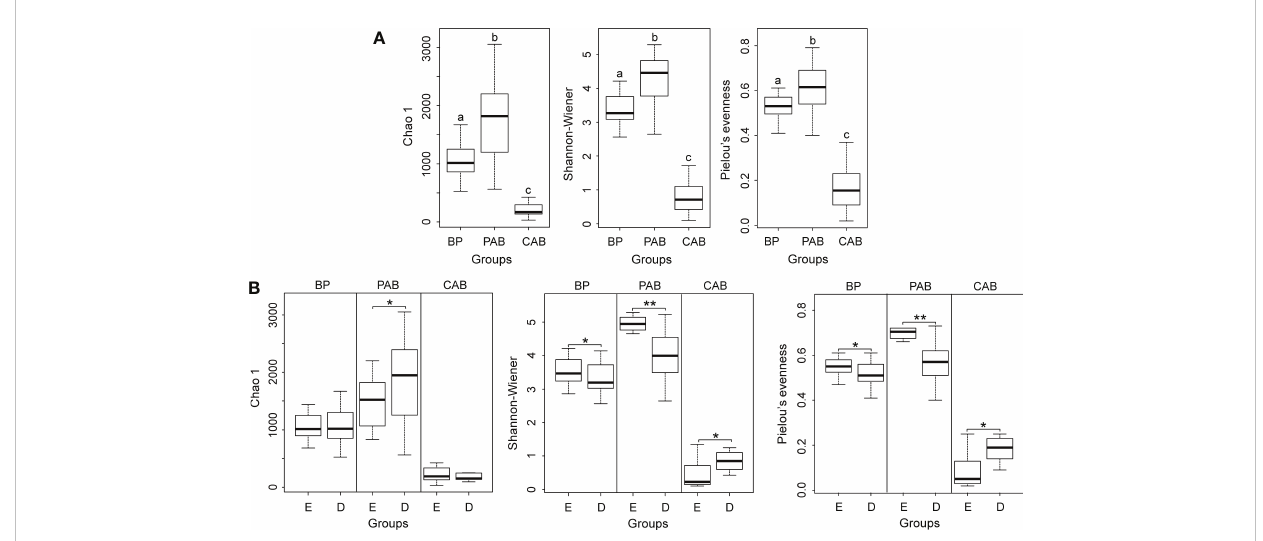
FIGURE 4 Boxplot of a -diversity indices on genus level among three kinds of bacteria (A) Different lowercase letters represent signi fi cant differences, p < 0.01 and between exponential and decline growth phases of Phaeocystis globosa bloom (B) . BP, bacterioplankton; PAB, particle-attached bacteria; CAB, colony-attached bacteria; D, exponential growth phase of bloom; E, decline growth phase of bloom. * p < 0.05; ** p <